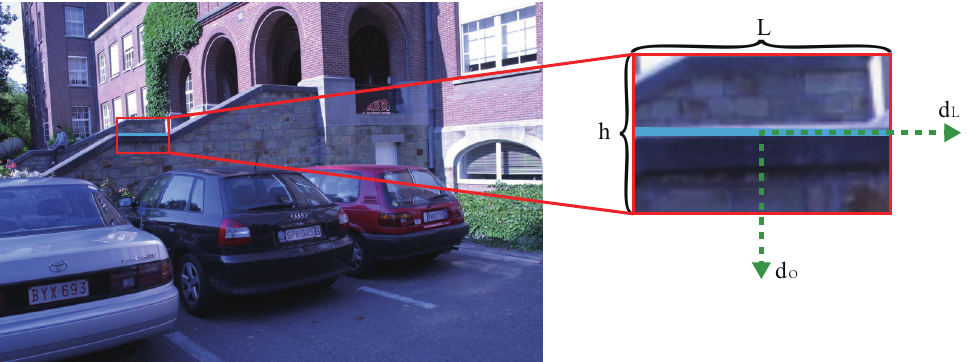
Figure 2. Line support region generation